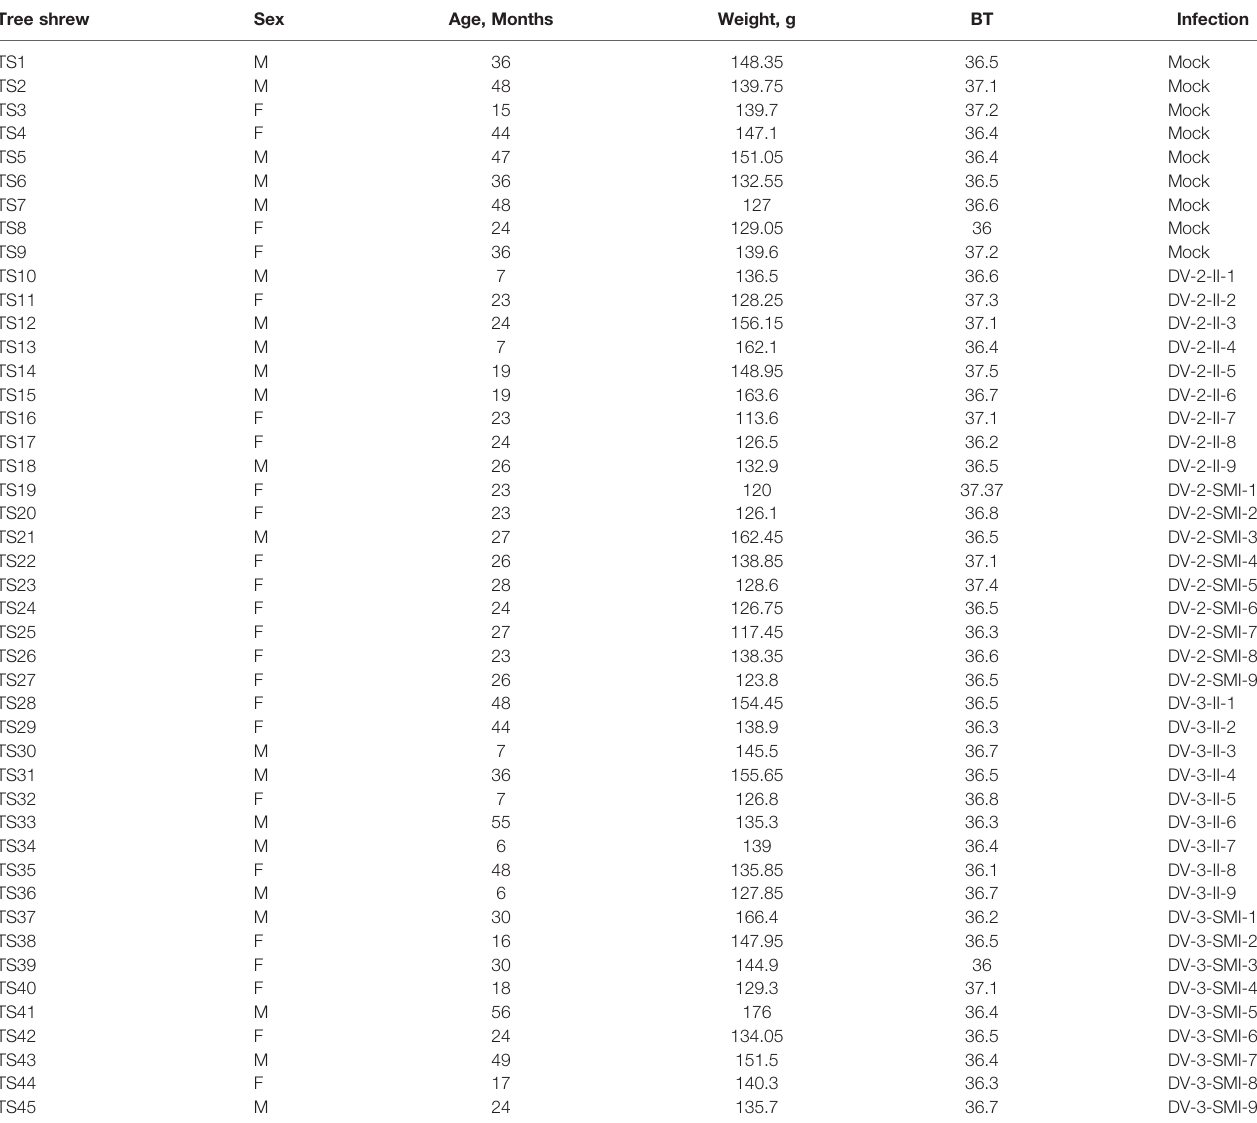
TABLE 1 | Speci fi cations of tree shrews. Tree shrew Sex Age,